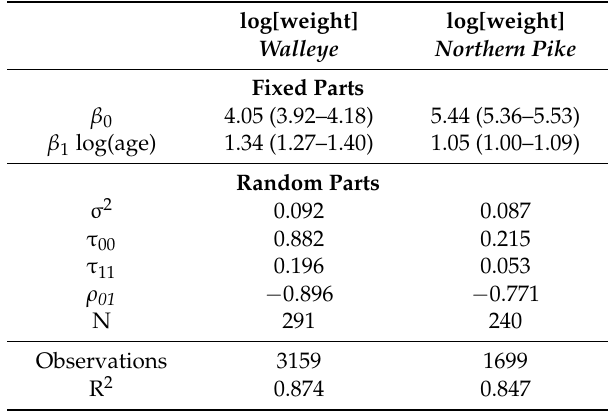
Table 5. Summary statistics of LMEMs describing fine-scale (waterbody-level) variation in body mass as a function of age with each unique waterbody sampled treated as a random effect for Walleye and Northern Pike. (Note: numbers in parenthesis show 95% confidence